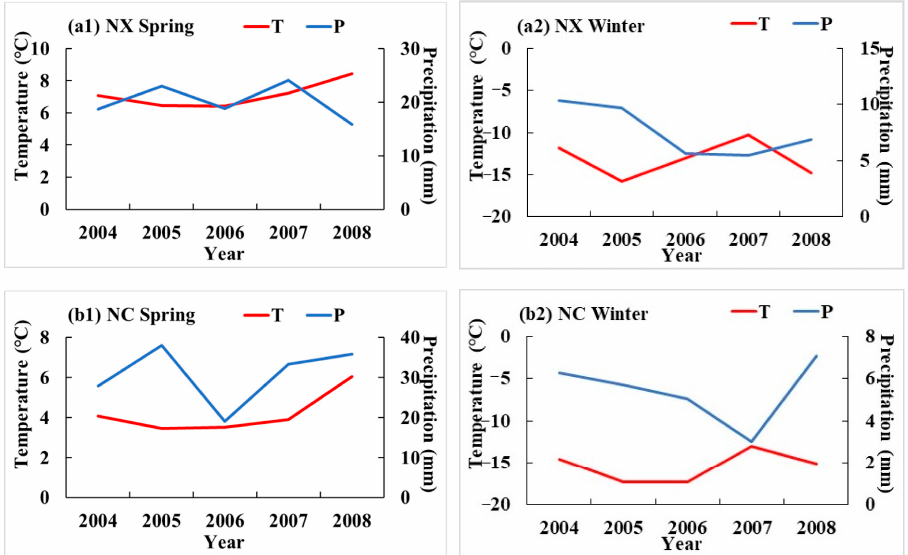
Figure 11. Annual variation between the temperature and precipitation of NX ( a1 – a2 ) and NC ( b1 – b2 ) from 2004 to 2008. The red line represents temperature and the blue line represents precipitation.